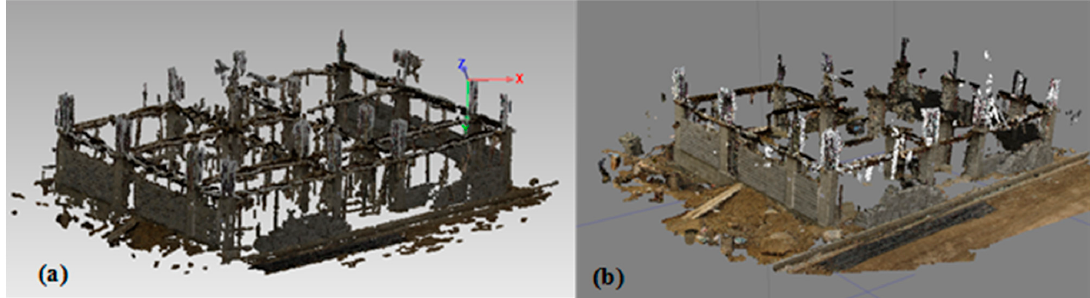
Figure 12. The generated point cloud: ( a ) SFM/CMVS/PMVS algorithm and ( b ) proposed photogrammetric Multi ‐ View Stereo method (Case study